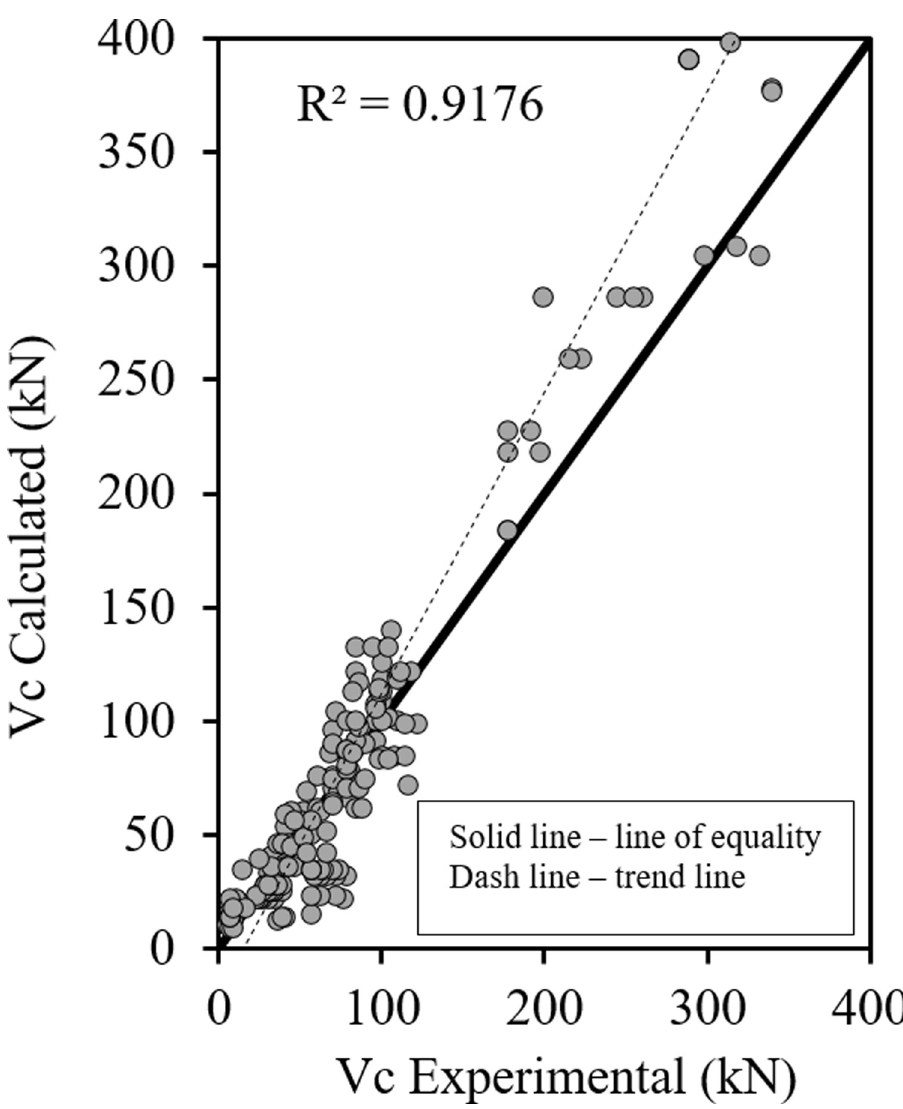
Fig 5. Shear strength of HSC beams (Eq 7).